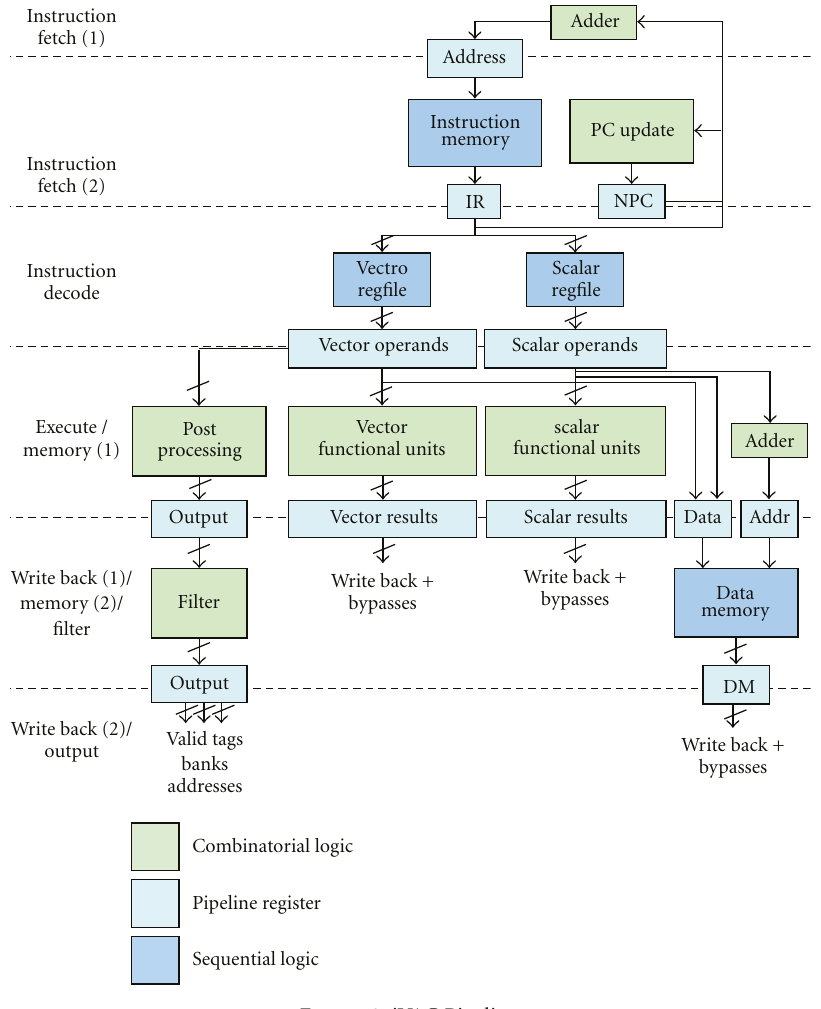
Figure 3: iVAG Pipeline.